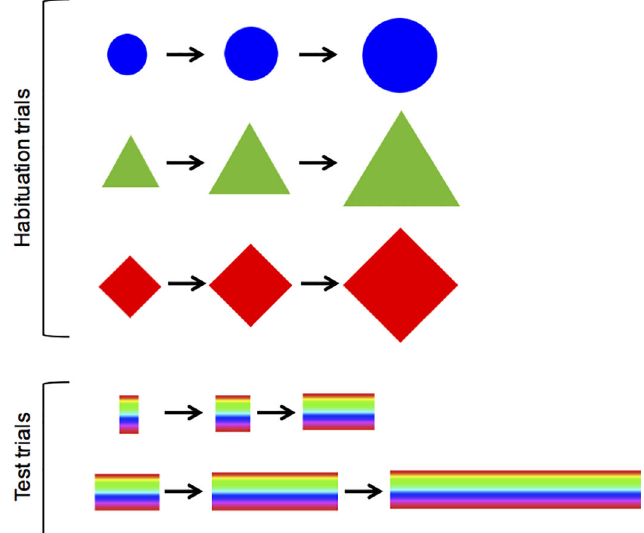
Figure 1. The five sets of colored shapes as they were presented to infants in the increasing order condition of Experiment 1. Arrows represent passage of time; objects were presented serially, centered on the screen. Blue circles, green triangles, and red diamonds were presented in a fixed order during habituation, and the smaller and larger sets of rainbow-colored bars were presented, respectively, during the against-OM and the with-OM test trials, with presentation order counterbalanced across participants. For infants in the decreasing order condition the same habituation shapes were presented in reversed order (from the larger to the smaller), starting from the red diamonds and proceeding to the green triangles and the blue circles, and the smaller and larger sets of bars were presented, respectively, during the with-OM and the against-OM test